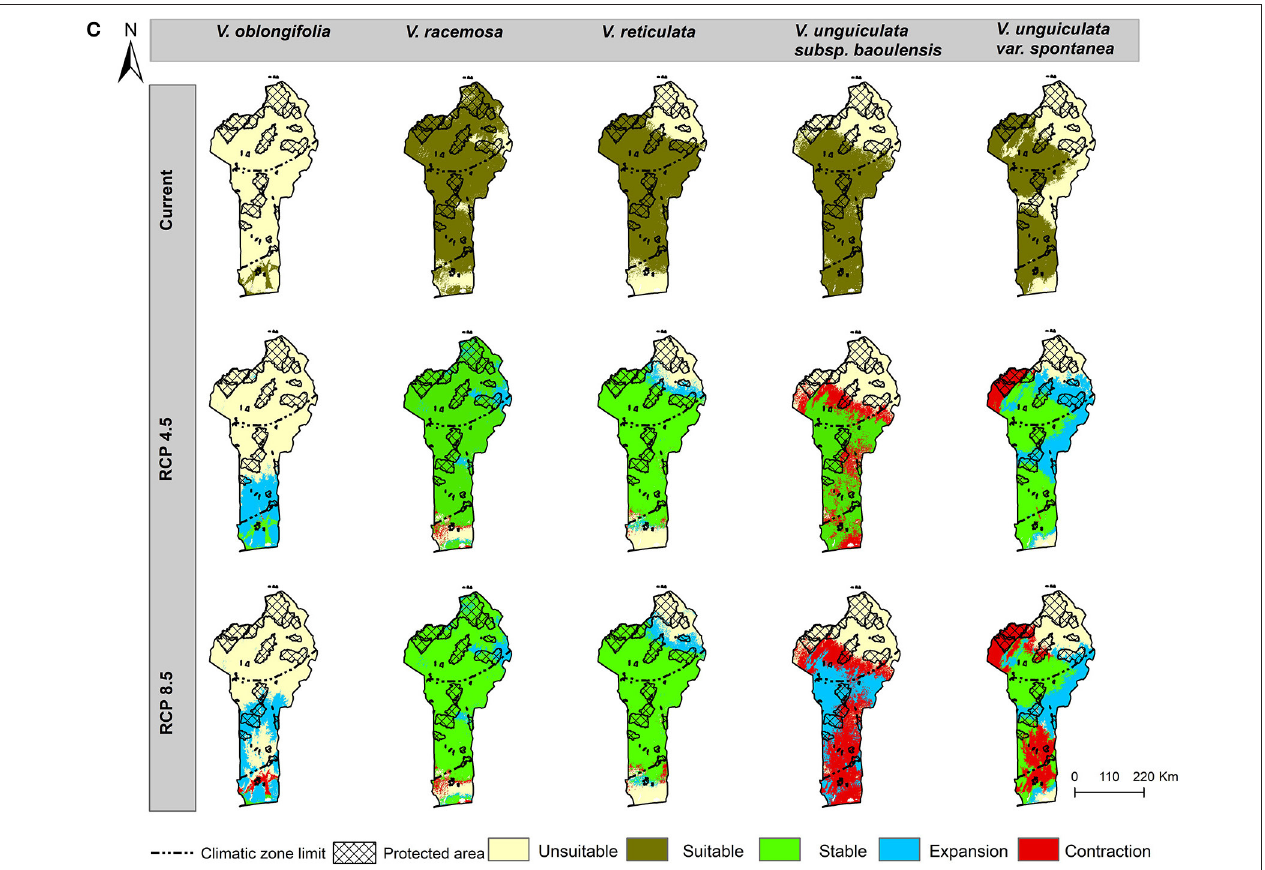
FIGURE 3 | (A–C) Predicted distribution maps of the 15 Vigna CWR taxa in Benin under the current and future climates.